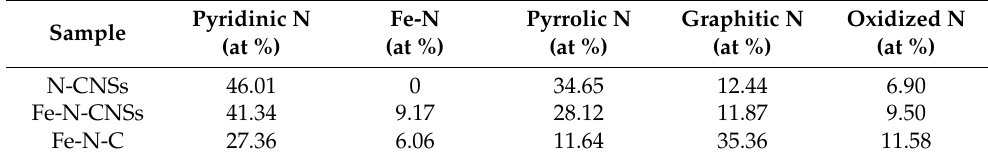
Table 2. The relative contents of various N existing forms were measured by